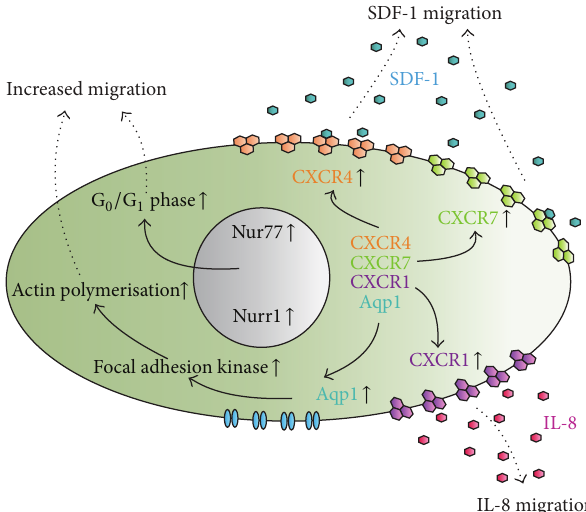
Figure 2: MSCs engineered to enhance migratory properties. Increased MSC migration could be accomplished by membrane- bound receptor engineering (i.e., CXCR1, CXCR4, and CXCR7), water channel receptors (Aqp1), or the upregulation of defined nuclear receptors (i.e., Nur77 and